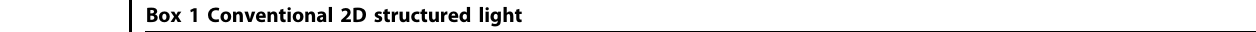
proposed to represent general structured Gaussian modes. In contrast to the prior PS model which represents a light pattern by a speci fi c point on the sphere, the Majorana sphere (Fig. 2c) depicts a structured mode by a set of points located on the sphere, revealing hidden symmetry to extend structured light 18,19